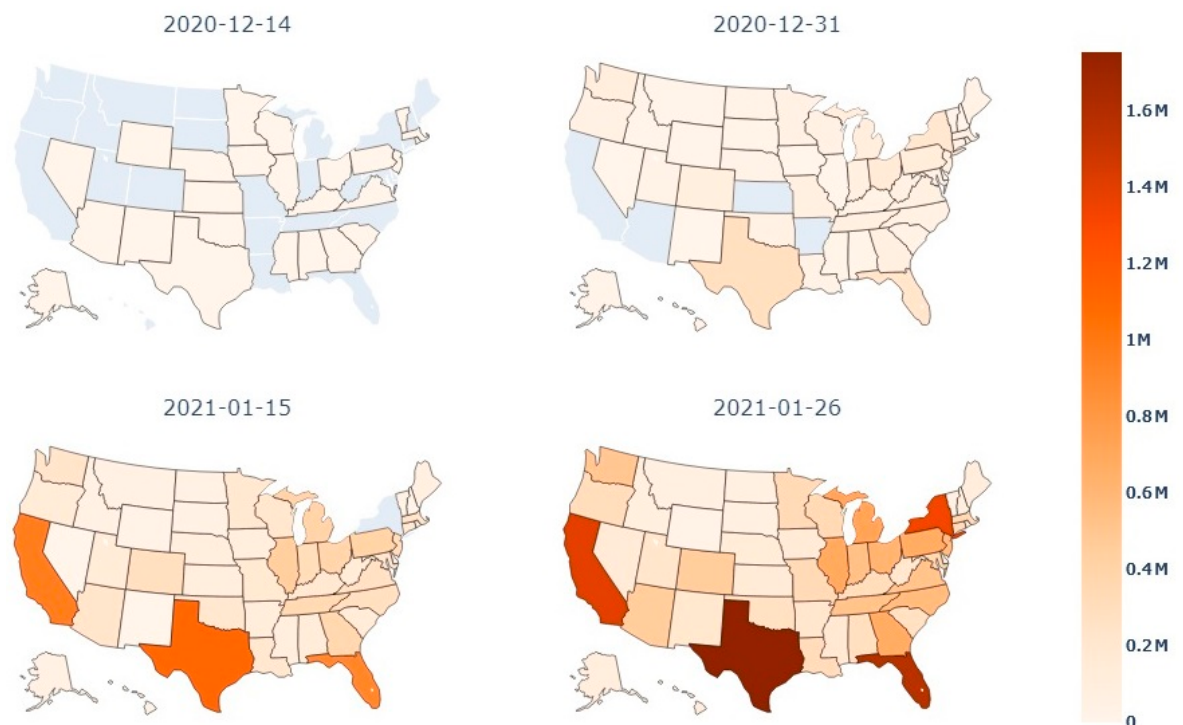
Figure 1. Cumulative number of vaccination doses administered in each state at specific dates during the study period (Source: the Johns Hopkins University Centers for Civic Impact COVID-19 data analysis and visualizations repository).